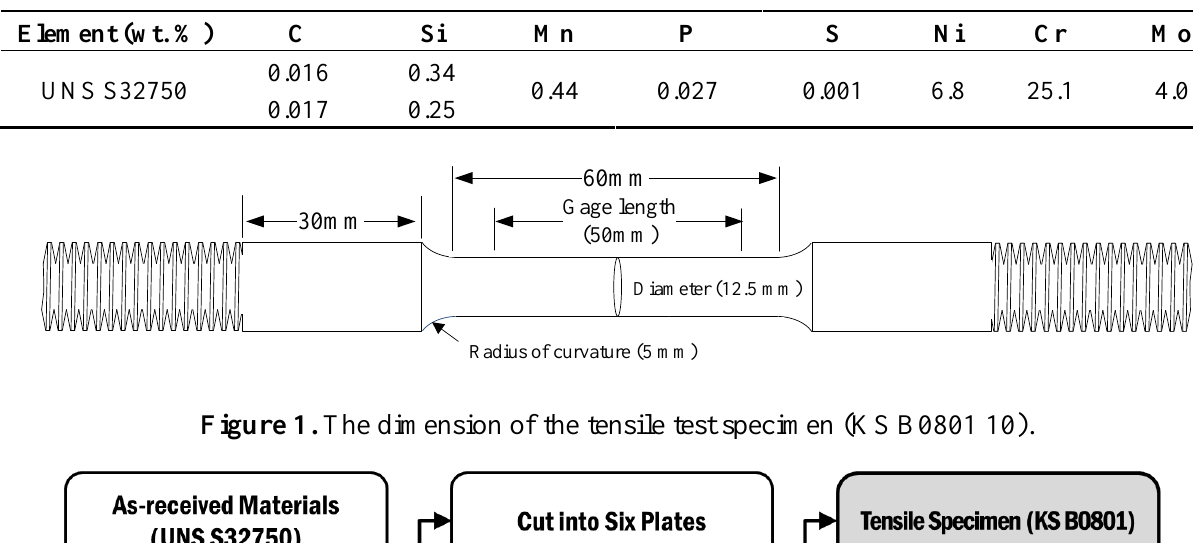
Table 1. Chemical composition of experimental specimens.